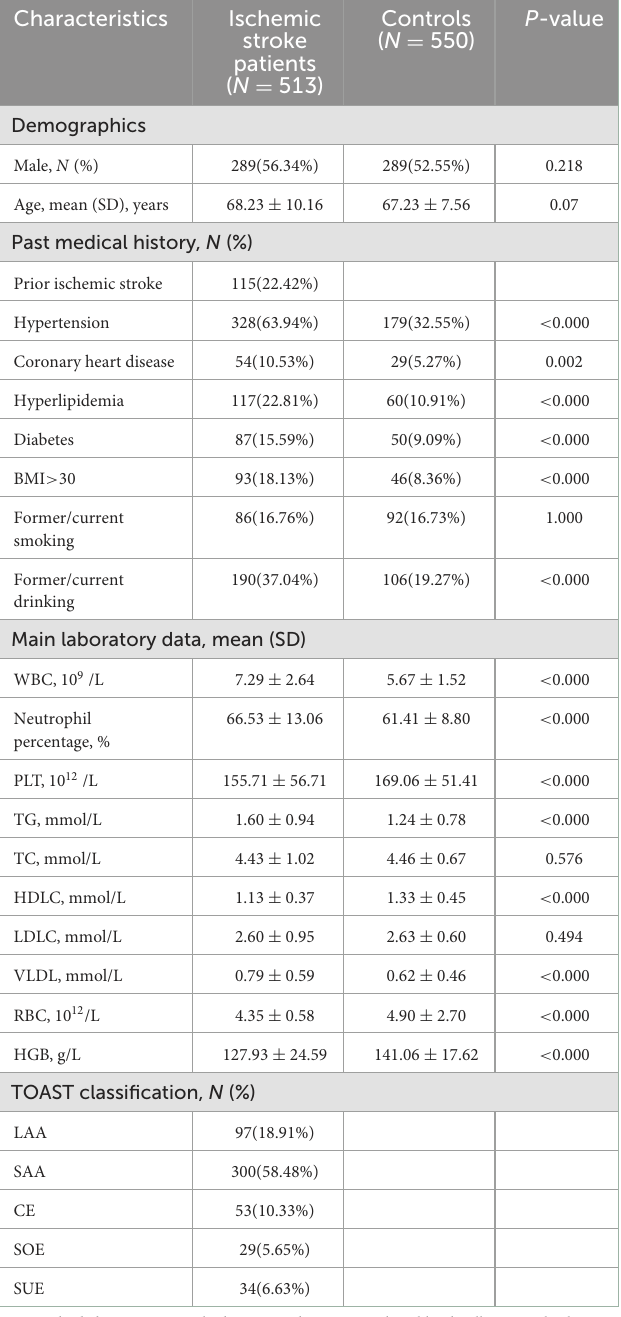
TABLE 1 Characteristics of the study